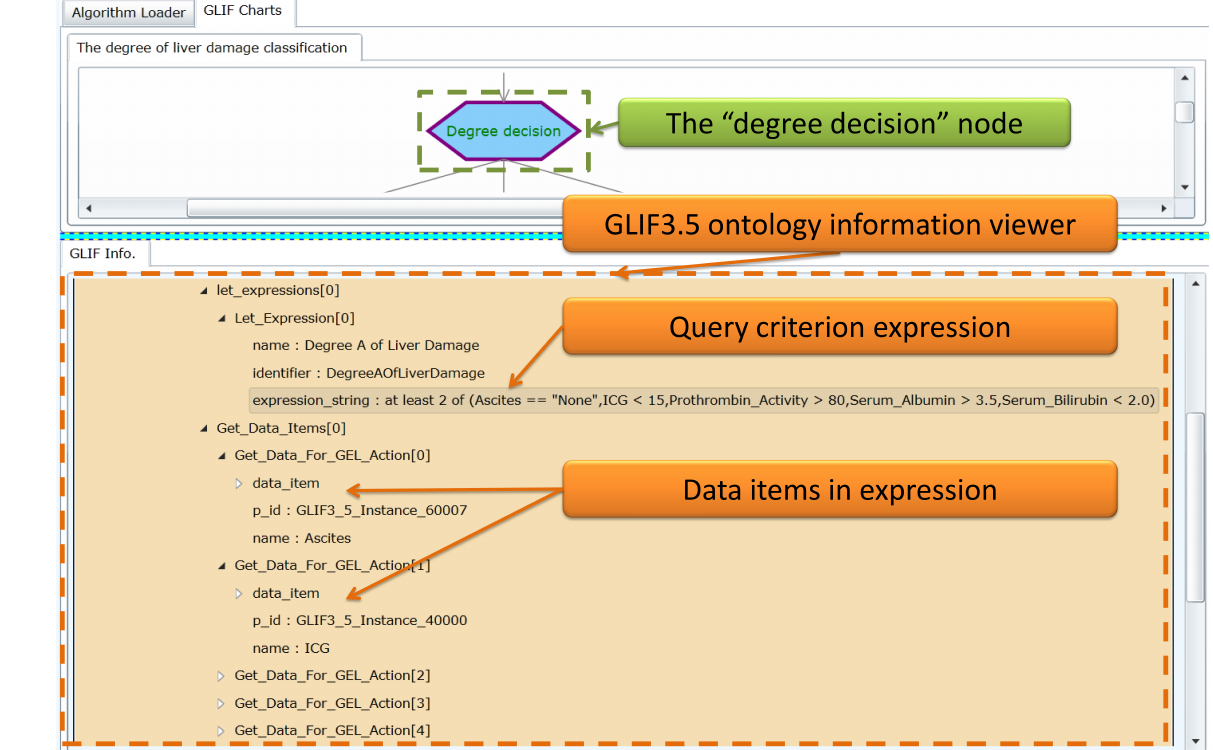
Figure 7. The GLIF3.5 ontology information viewer. The selected node, “degree decision,” and its corresponding information in GLIF3.5